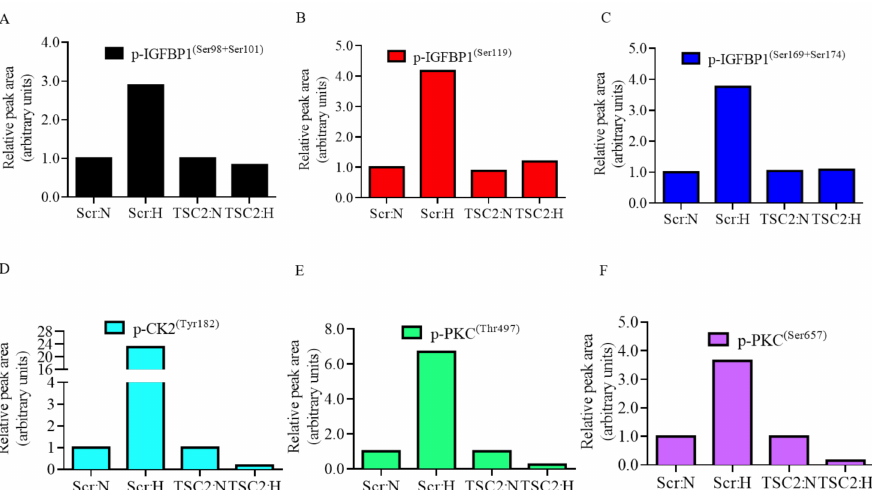
Figure 8. PRM-MS to monitor relative site-specific phosphorylation in response to TSC2 silencing in hypoxia. PRM-MS analysis for detection of relative phosphorylated IGFBP-1 at phosphorylation sites p-IGFBP-1 (Ser98+Ser101) ( A ), p-IGFBP-1 (Ser119) ( B ), and p-IGFBP-1 (Ser169+Ser174) ( C ) in decidualized primary HESCs transfected with TSC2 or Scramble (Scr) siRNA in normoxic (N) and hypoxic (H) conditions. Phosphorylation of IGFBP-1 co-immunoprecipitated CK2 and PKC kinases was also monitored to determine activation status; p-CK2 (Tyr182) ( D ), p-PKC (Thr497) ( E ), and p-PKC (Ser657) ( F ) were individually monitored in TSC2 or Scr siRNA conditions. Data was collected using a Q- Exactive hybrid quadrupole-Orbitrap mass spectrometer. Values are displayed as relative peak area of total detected transitions and normalized by an internal IGFBP-1